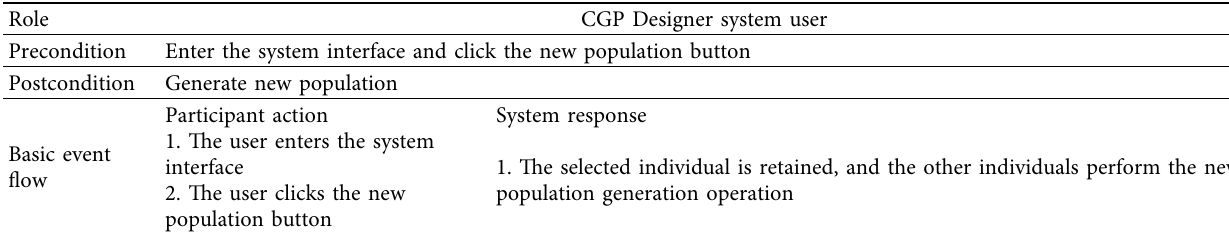
Figure 10: User case diagram of the client. Table 3: Use case rules for generating new